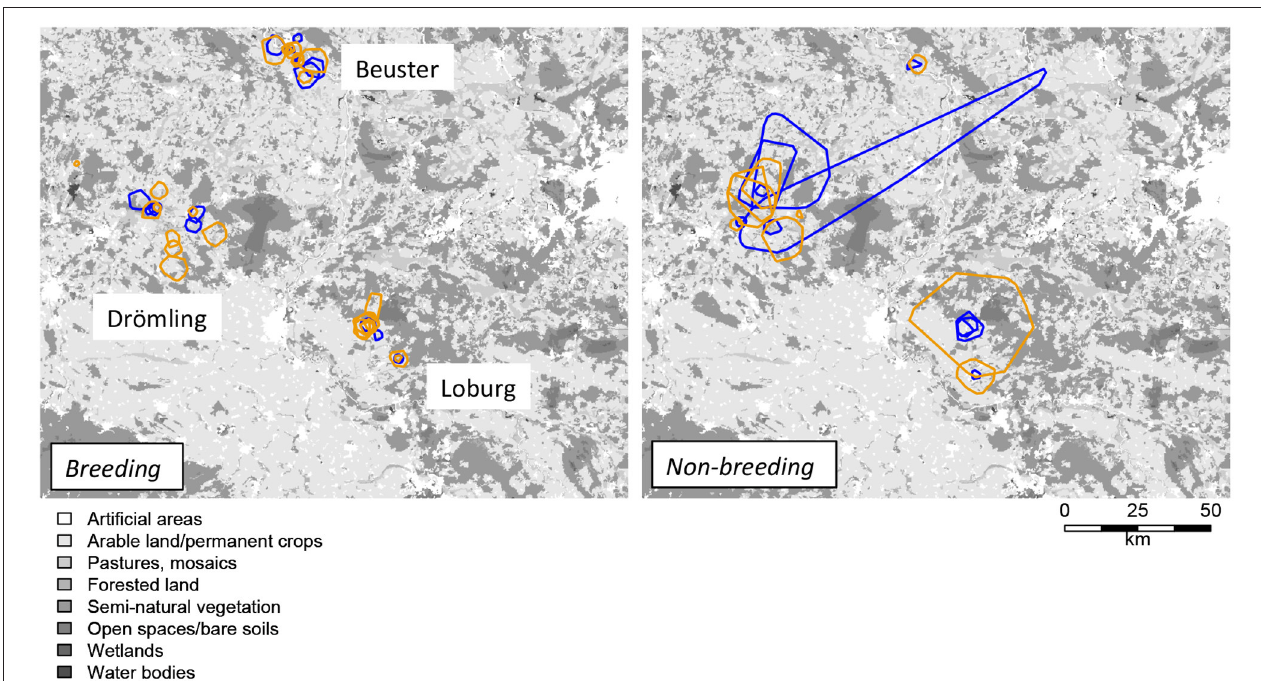
FIGURE 1 | Home ranges of breeding and non-breeding (including brood loss) white storks in years 2013 (blue) and 2014 (orange). Presented are the 95% minimum convex polygons. Gray shading indicates Corine land cover types from 2006; for a colored version of land cover map See Supplementary Figure